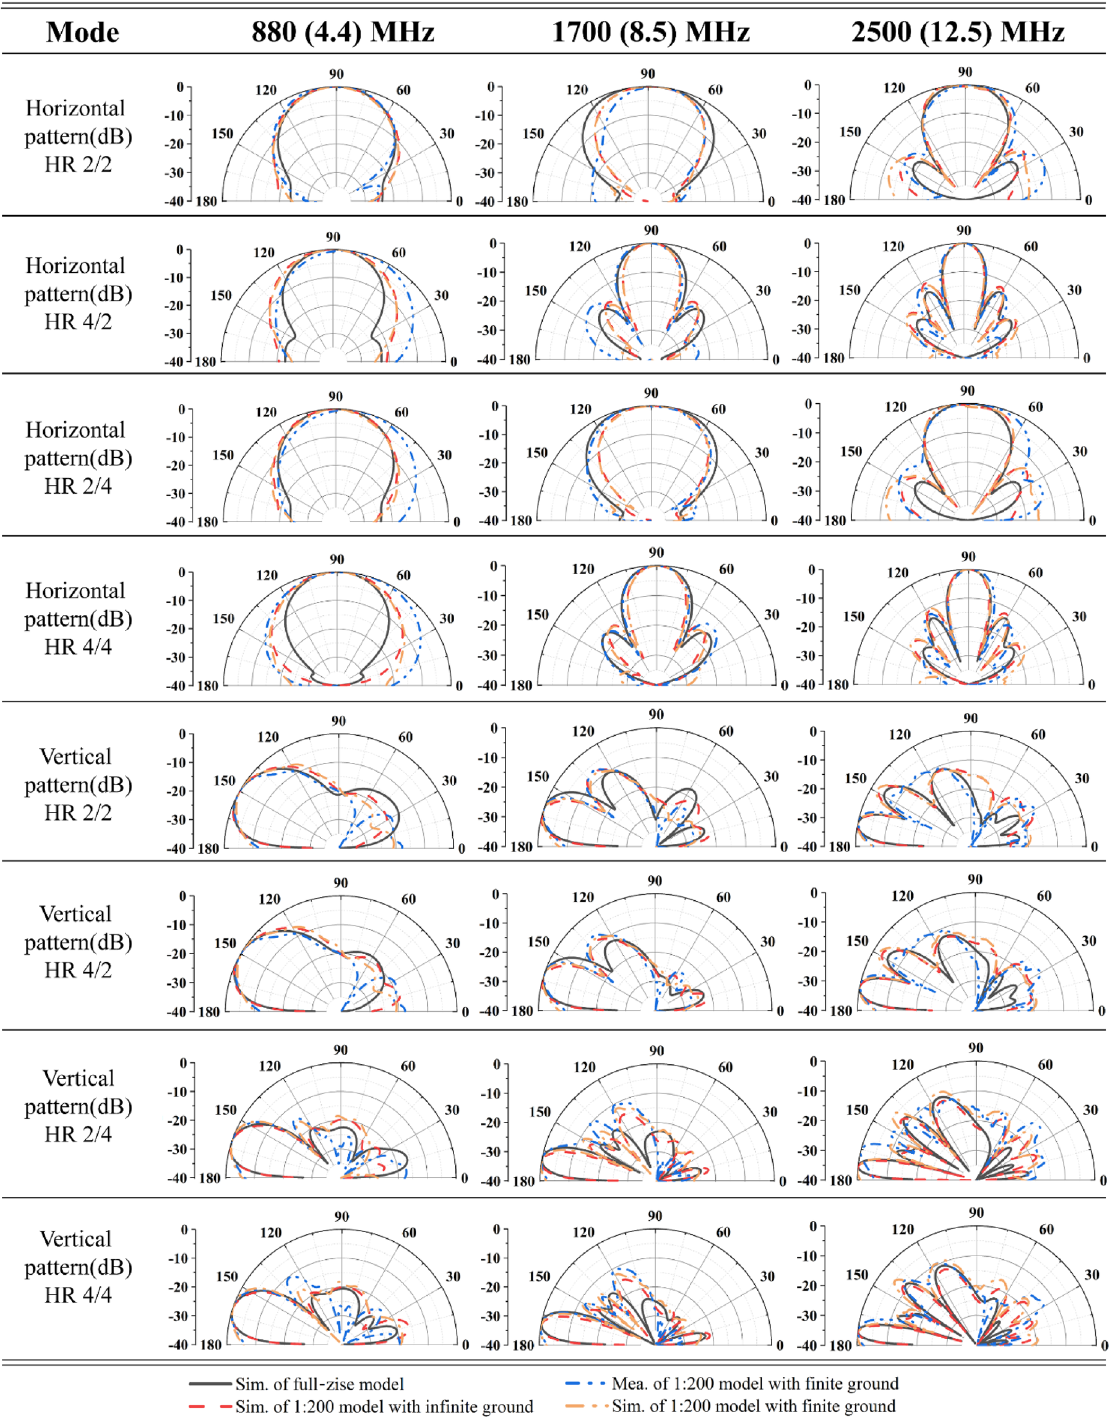
Figure 10. Simulation and measurement of patterns for each